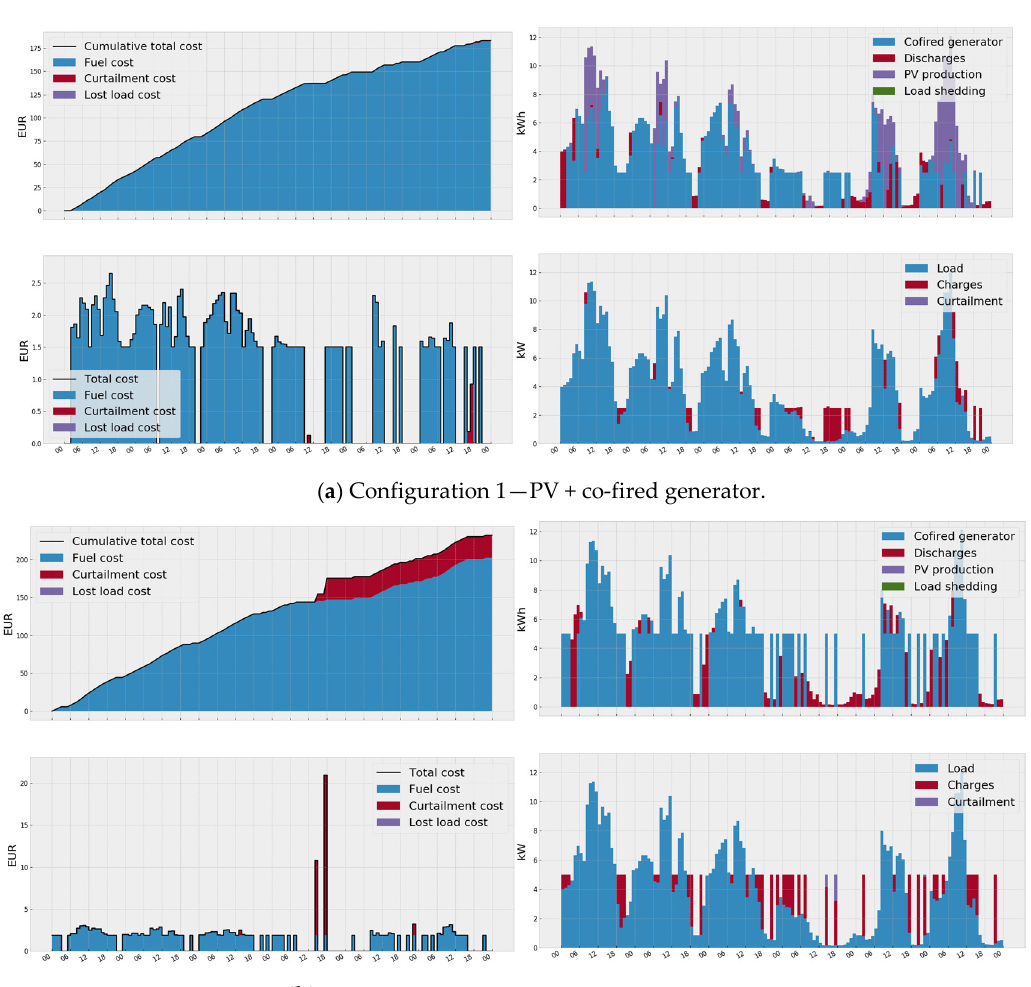
Figure 5. Total costs (left) and generation/load mix (right) of different microgrids with co-fired generators for optimal policies, π ∗ obtained using MCTS for the one-week testing period.